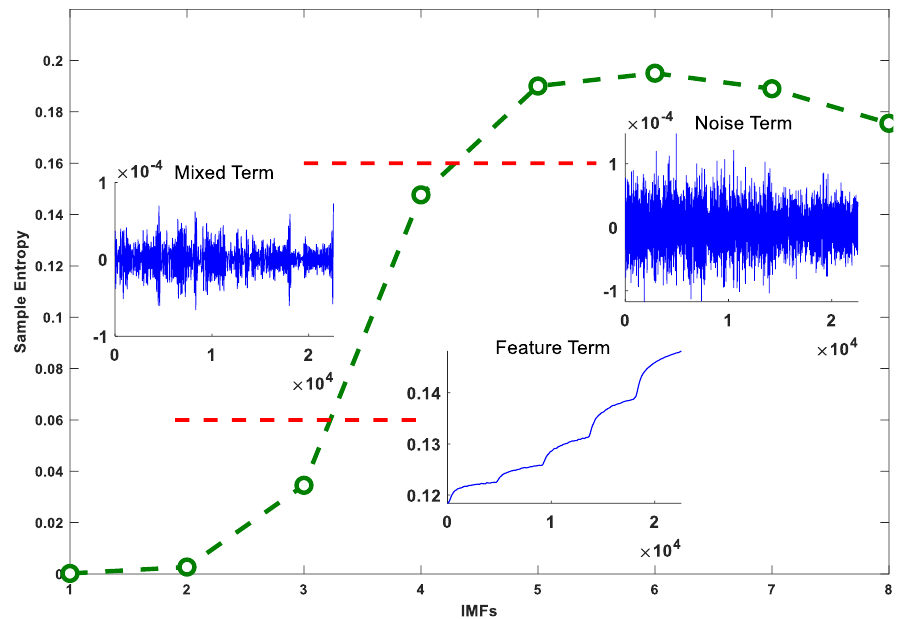
Figure 13. The calculation and classification results by SE.